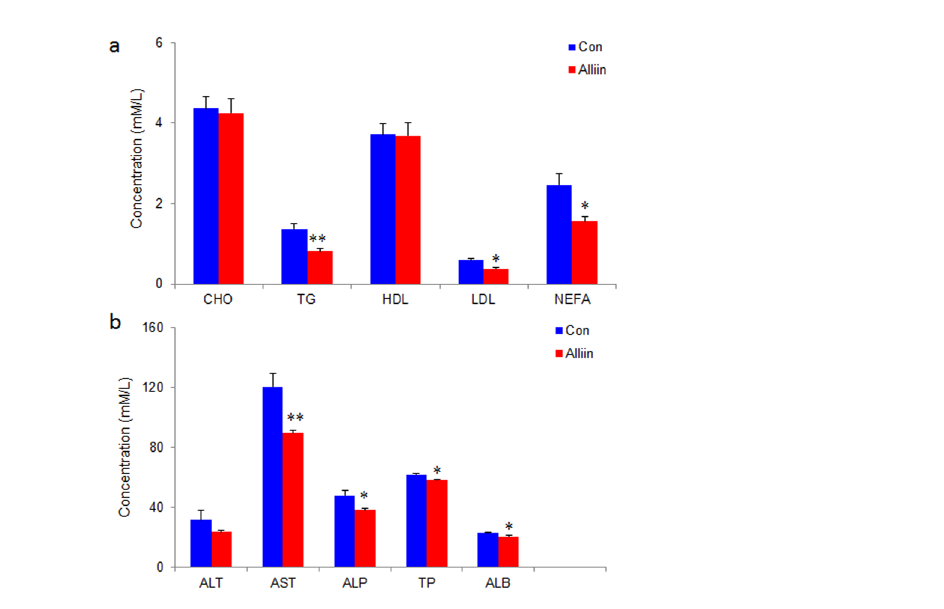
Figure 2. Biochemistry of blood of alliin treated DIO mice. Alliin improved ( a ) the lipid profile and ( b ) the liver function of DIO mice. Data are means ± SEM (n = 10). * P < 0.05, ** P < 0.01. CHO, cholesterol; TG, triglyceride; HDL, high density lipoprotein; LDL, low density lipoprotein; NEFA, non-esterized free fatty acid; ALT, alanine aminotransferase; AST, aspartate aminotransferase; ALP:Palkaline phosphatase; TP, total protein; ALB,